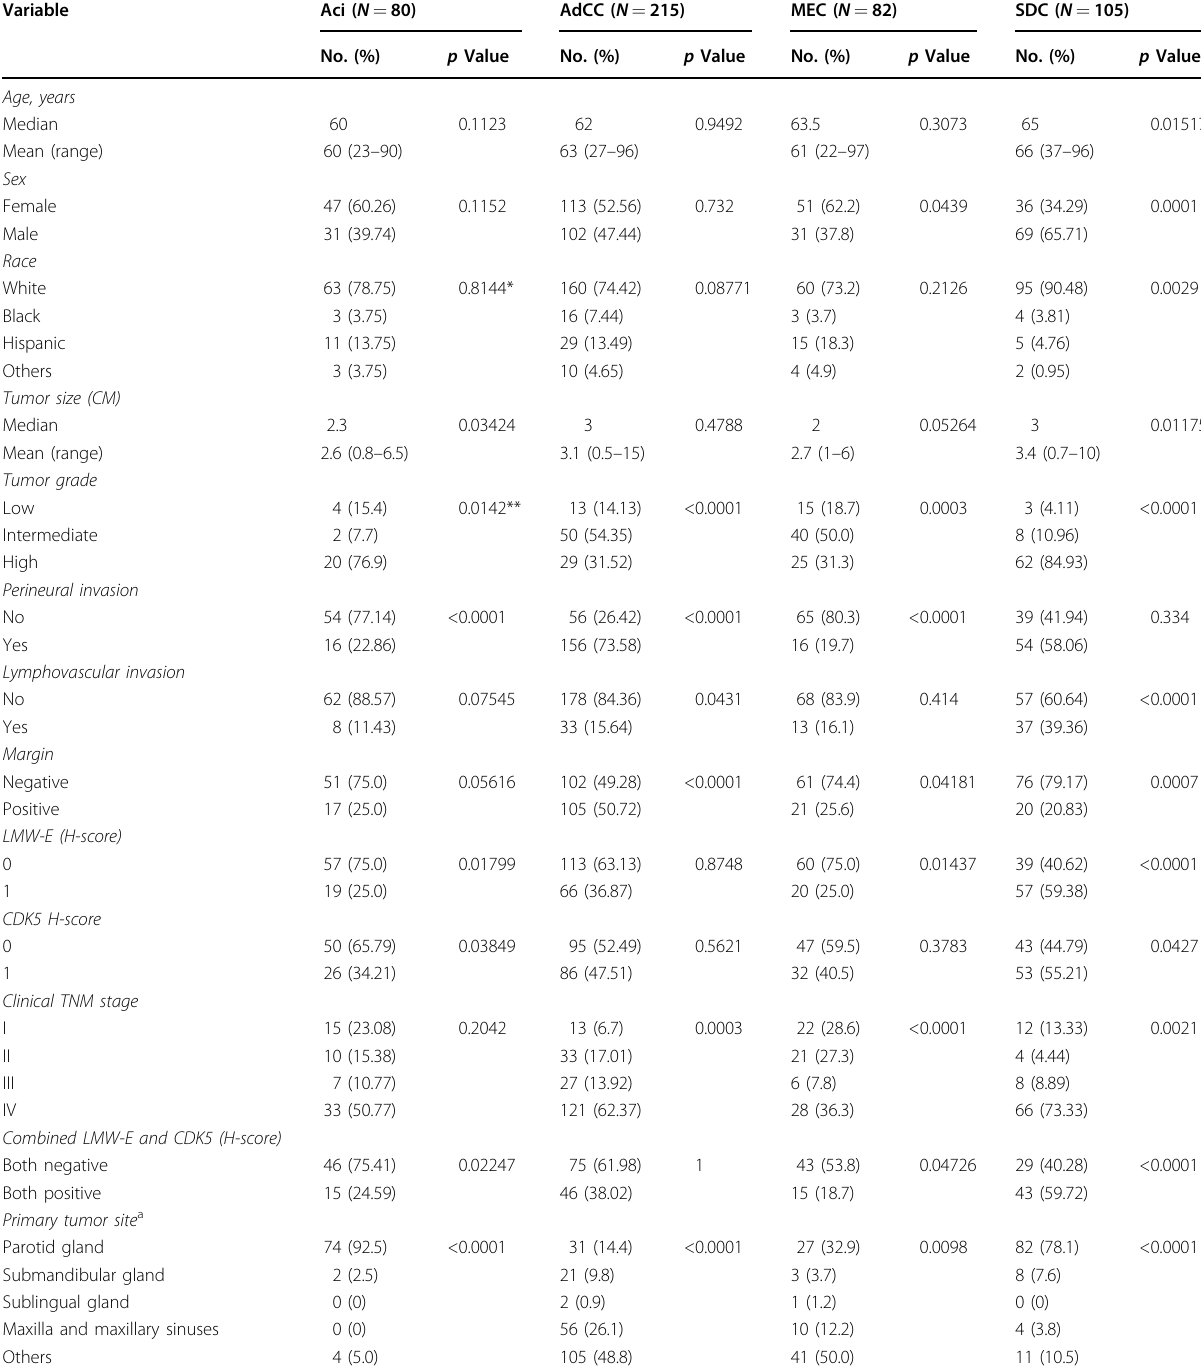
Table 1 Summary of clinicopathologic variables in salivary gland cancer patients.